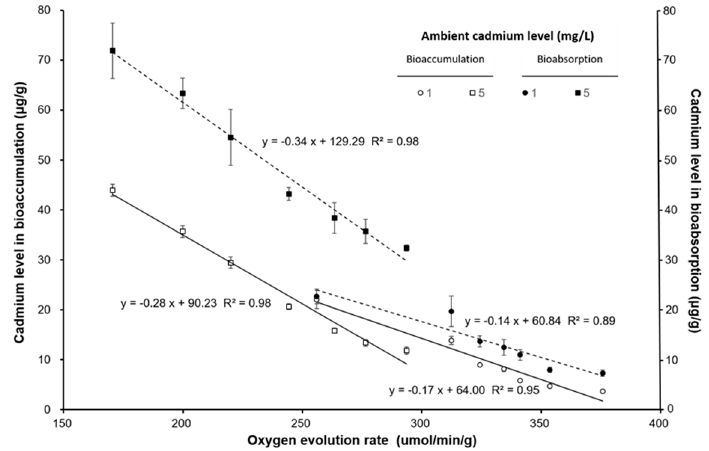
Figure 5. The relationship between the cadmium content in seaweed bioaccumulation ( µ g / g) and bioabsorption ( µ g / g) with the oxygen evolution rate ( µ mol / min / g) on S. suiae exposed to 1 and 5 Cd 2 + mg / L.